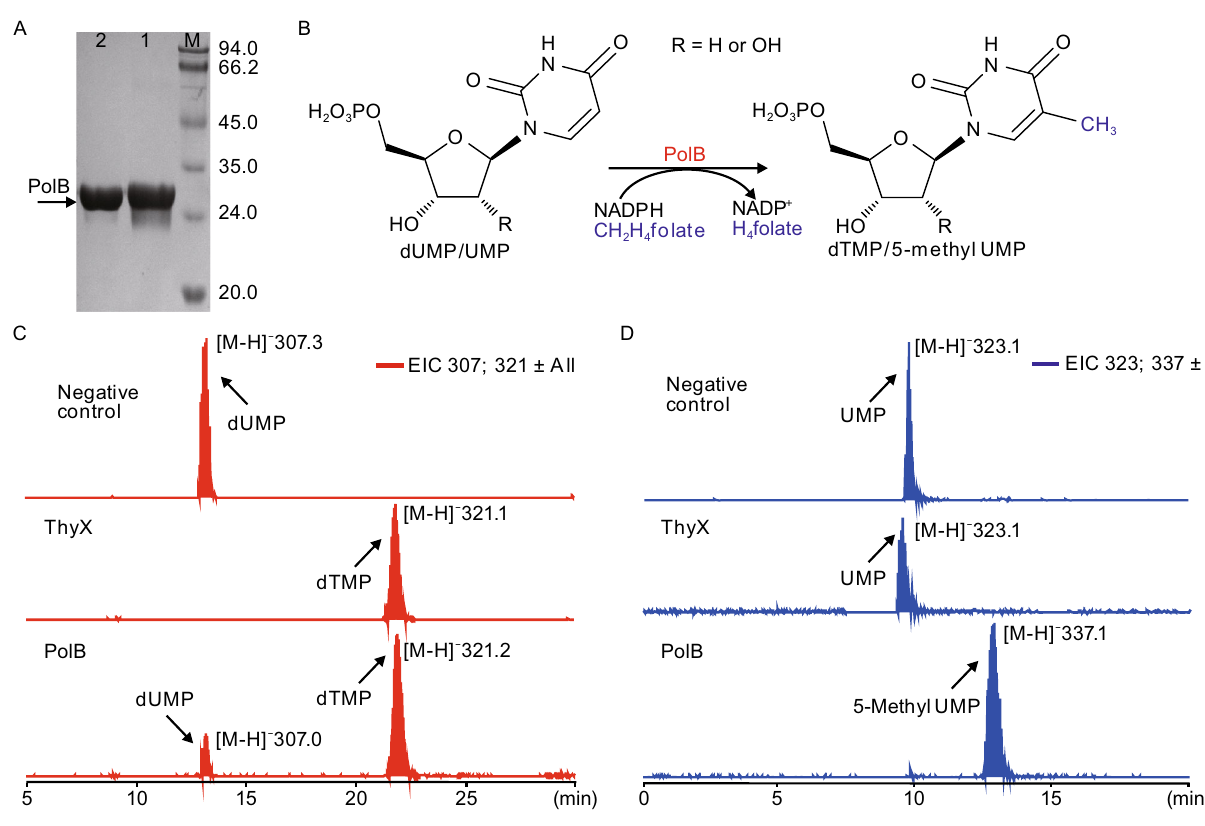
Figure 3. In vitro characterization of PolB as a UMP/dUMP methylase. (A) SDS-PAGE analysis of PolB. M, molecular weight marker; lanes 1 and 2, puri fi ed His 6 -tagged PolB. LC-MS analysis of the reaction products of dUMP by ThyX or PolB. (B) Scheme of PolB catalyzed UMP/dUMP methylation reactions. (C) LC-MS analysis of the reaction products of ThyX or PolB using dUMP as substrate. Negative control, no PolB or ThyX was added into the reaction mixture. (D) LC-MS analysis of the reaction products of ThyX or PolB using UUMP as substrate. Negative control, no PolB or ThyX was added into the